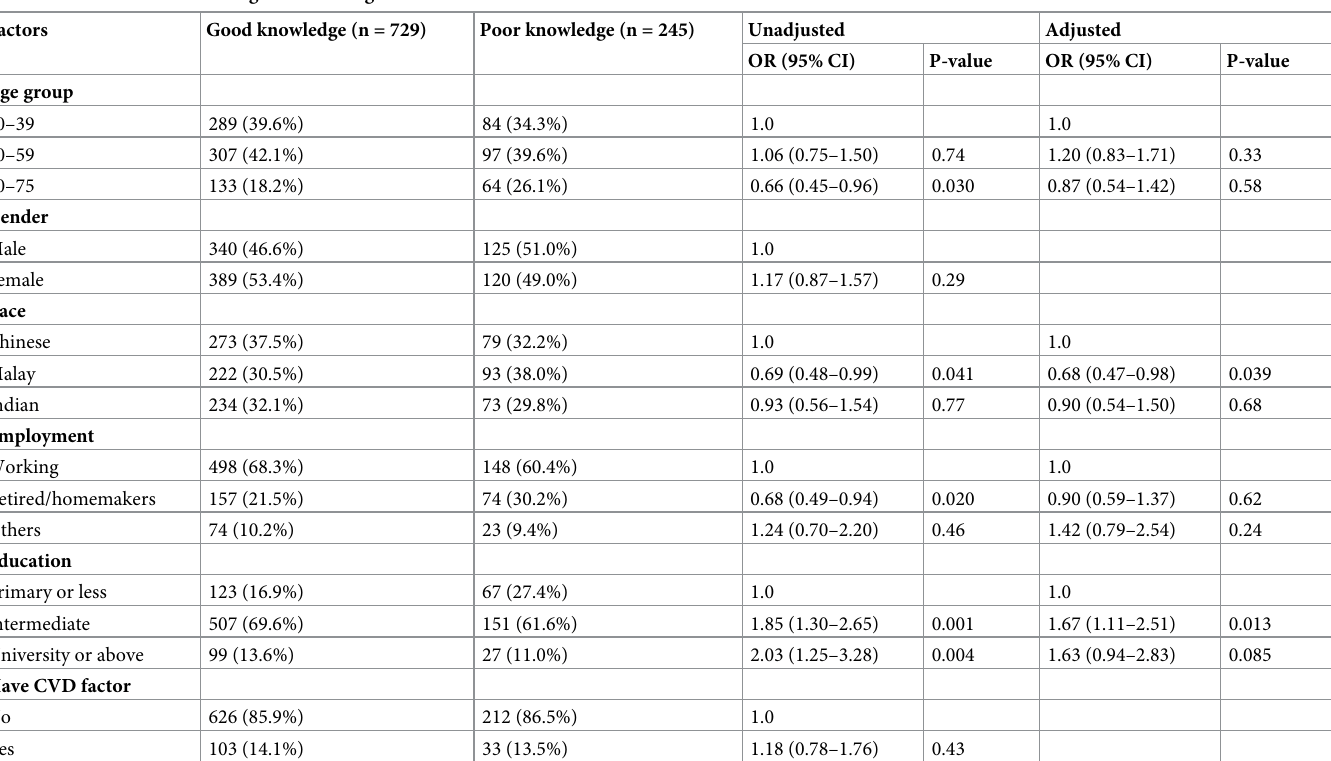
Table 3. Factor associated with good